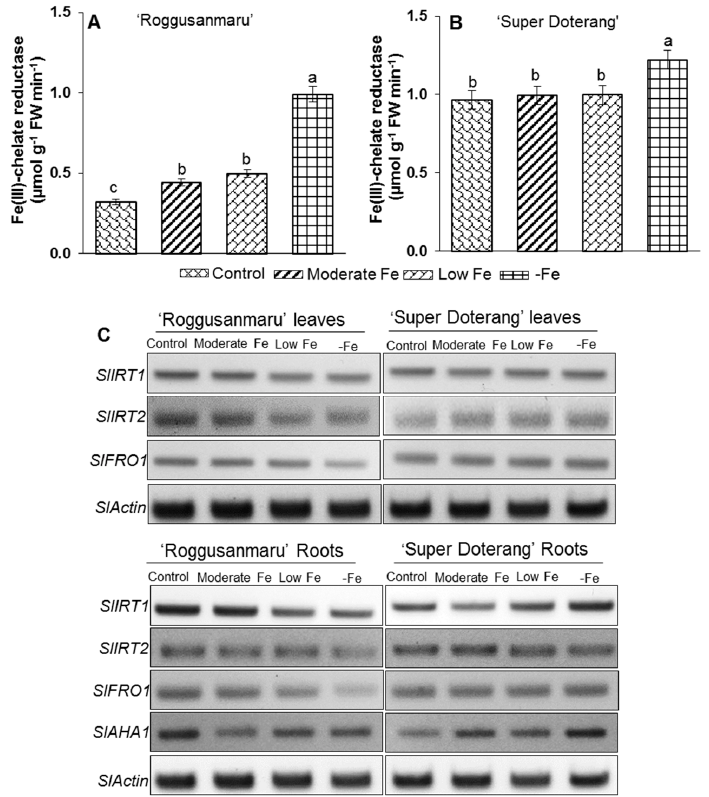
Figure 8. ( A , B ) Fe(III) chelate reductase activity in roots and ( C ) semi-quantitative RT-PCR analysis of Fe transport SlIRT1 , SlIRT2 and Fe(III) chelate reductase SlFRO1 , SlAH1 related genes in leaves and roots of “Roggusanmaru” and “Super Doterang” tomato cultivar ( SlActin acted as a normalized housekeeping gene). Plants were grown in Fe-sufficient (control); moderate Fe; low Fe; and Fe-deficient (–Fe) Hoagland nutrient medium for 10 days. Significant differences ( p ≤ 0.05) among treatments are designated by different letters a, b, c according SAS analysis.